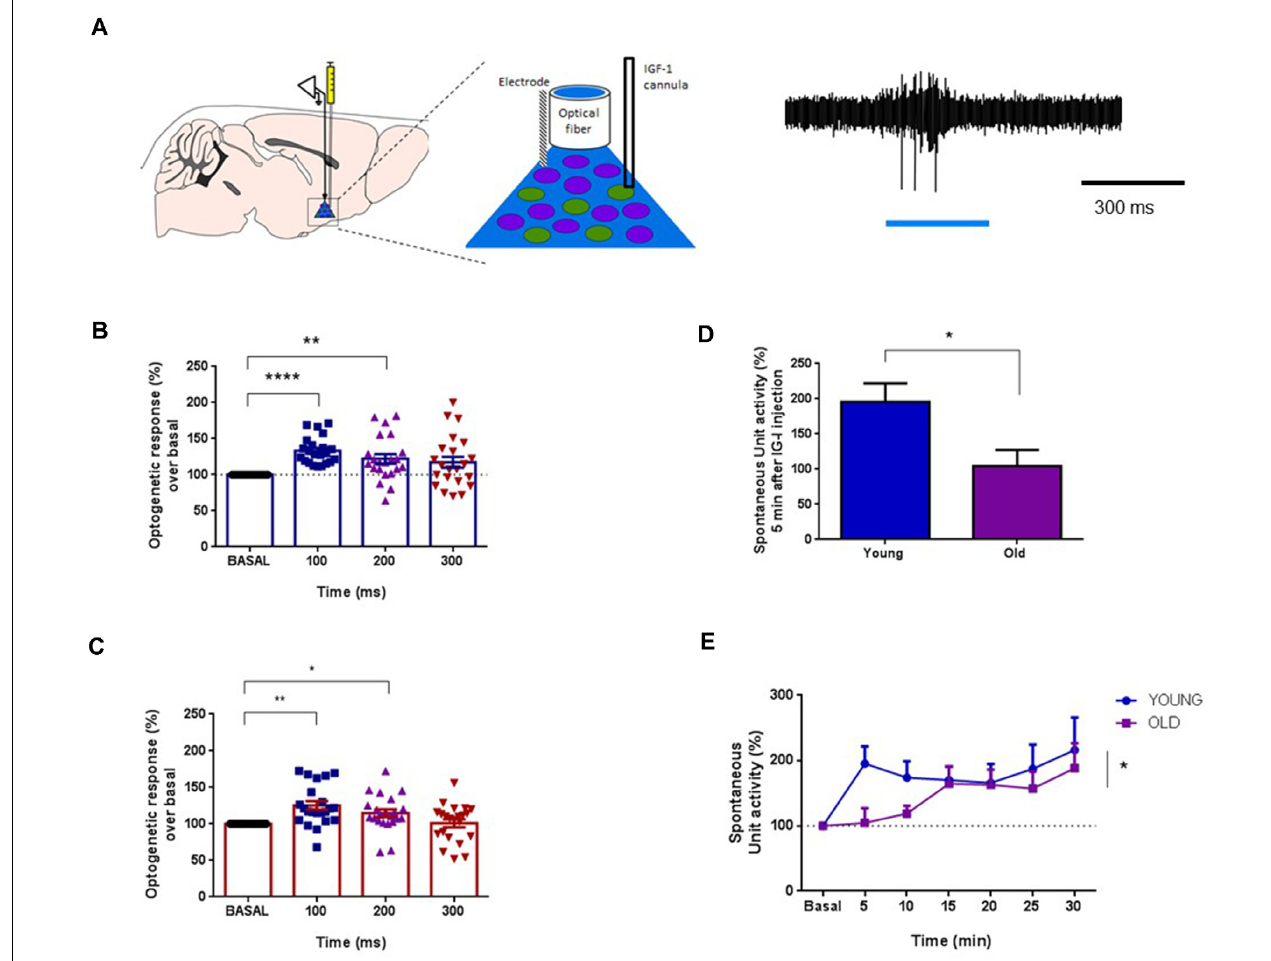
FIGURE 6 | IGF-I increased the activity of optogenetically identified ChAT+ cells. (A) Left panel: diagram of the location of the optrode and the cannula in the HDB area. Right panel: optogenetic identification using blue-light pulse (blue bar). Light pulse evoked a spike discharge. (B) Plot of the percentage of spike firing with respect to basal activity evoked by the blue-light pulse in young mice (ChAT-ChR2-YFP mice; < 6 months old). The firing rate was measured at 100 ms intervals. Neurons were identified as ChAT+ cells when their firing rate increased more than 10% with respect to basal activity in the 0–100 ms time interval. ChAT+ cells increased their firing rate to 133.3 ± 4.01% at 0–100 ms interval, or 122.2 ± 6.55% at 100–200 ms time intervals after the light-pulse onset ( F (2.040,42.85) = 9.216; n = 26 neurons; One-way Repeated Measure ANOVA; at basal vs. 0–100 ms: **** p < 0.0001, or 100–200 ms: ** p = 0.0078, Dunnett’s Multiple Comparison Test). (C) The same optogenetic identification of ChAT+ cells in old mice (ChAT-ChR2-YFP animals ≥ 20 months old) mice. The firing rate increased by light-pulses ( F (1.908,40.06) = 6.702, * p = 0.0035, n = 24; One-way Repeated Measure ANOVA; ** p < 0.0010 at 0–100 ms vs. basal activity, * p < 0.0277 at 100–200 ms; n = 24 neurons; Dunnett’s Multiple Comparison test). (D) IGF-I administration induced a 95.7% increase of the firing rate at 5 min in young animals while 4.5% of increase was observed in old animals ( n = 13 neurons per group; young = 19.57 ± 2.63 spikes/s; old = 10.45 ± 2.28 spikes/s; p = 0.0151; Unpaired t -test). (E) The time course of the IGF-I-evoked response of ChAT+ cells displays significant differences between both groups over time (young = 15, old = 13 neurons per group, * p = 0.0163; Ordinary Two-way